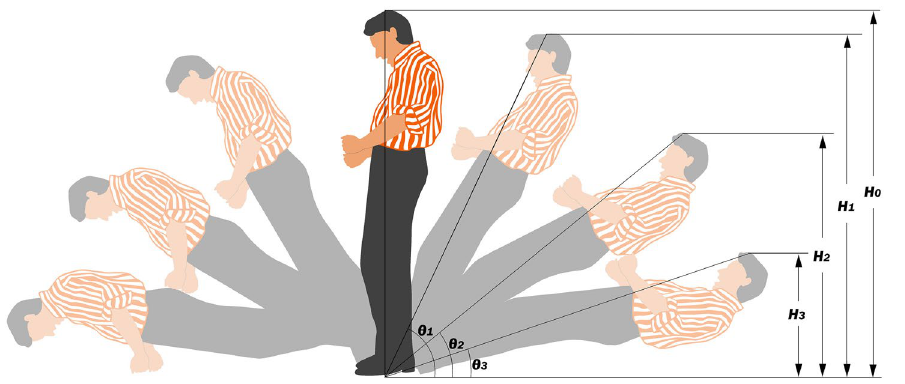
Figure 7. Change of apparent heights and tilt angles during a